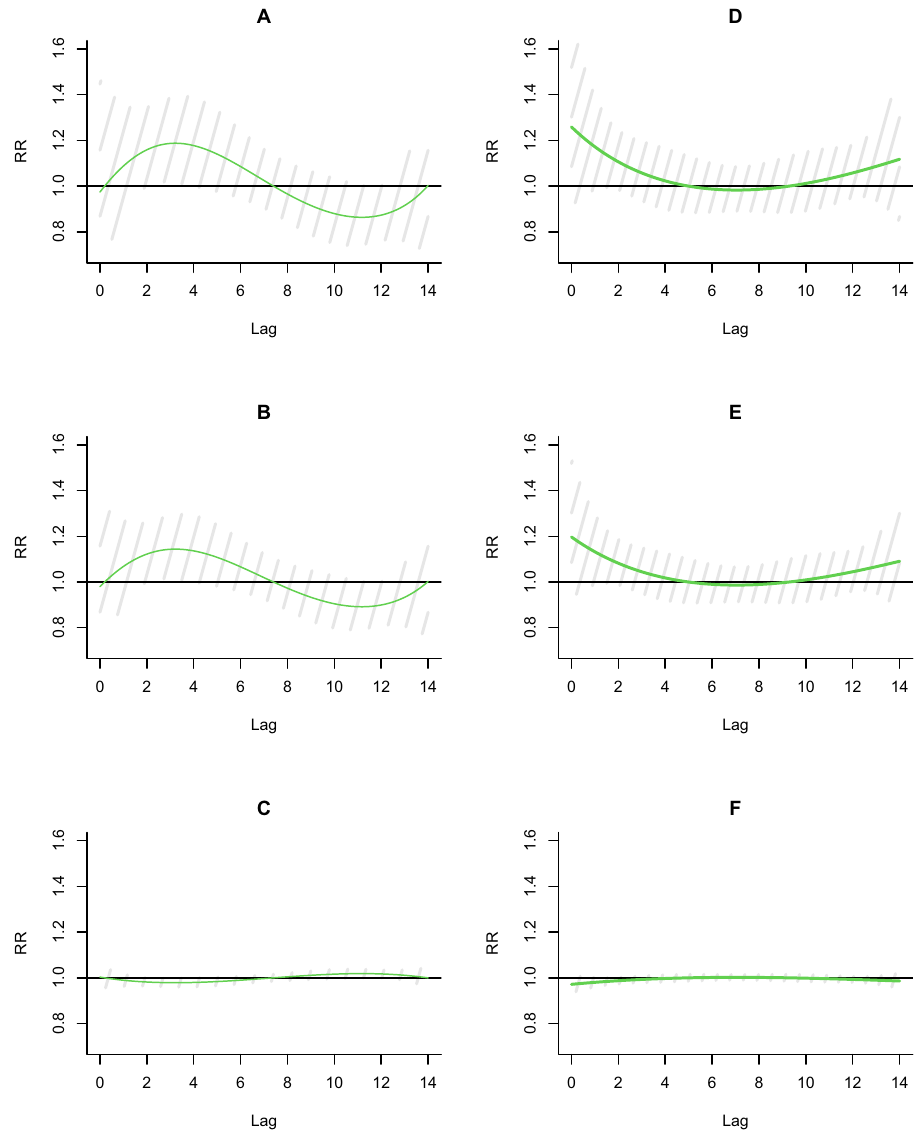
Figure 3. Lag effects of hospitalization risk of pneumonia exposure to low temperature and high temperature (≥ 65 years: ( A - C ) refer to the P5, P25, and P95 percentiles of daily average temperature, which are − 11.4 °C, − 3.6 °C, and 25 °C, respectively; < 65 years: ( D - F ) refer to the P5, P25, and P95 percentiles of daily average temperature, which are − 11.4 °C, − 3.6 °C, and 25 °C, respectively).